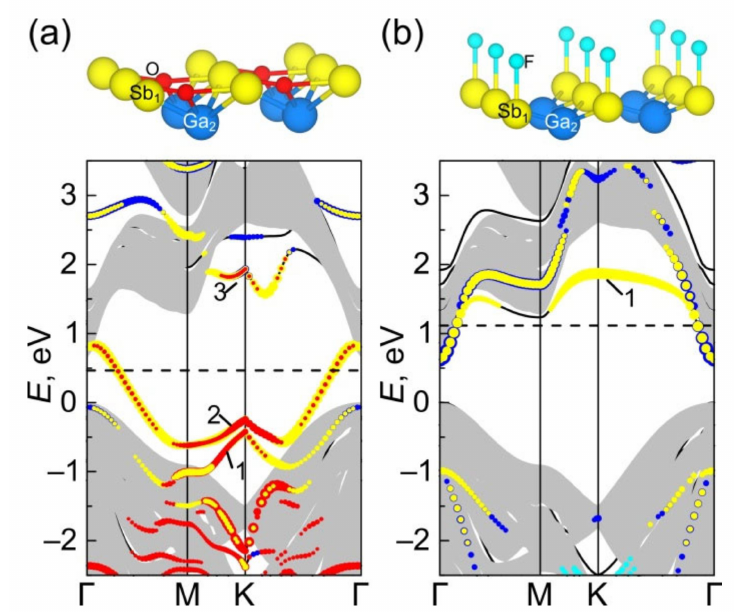
Figure 9. Atomic structure and electron energy spectrum in the case of GaSb(111)B surface with O adatom in Sb-B site ( a ) and with F adatom in Sb-T site ( b ). The surface states localized on Sb 1 , Ga 2 , O, and F atoms are shown by yellow, blue, red, and cyan balls, respectively. The denotations of the zero energy, the bulk states, the Fermi level, and the size of balls are the same as in Figure